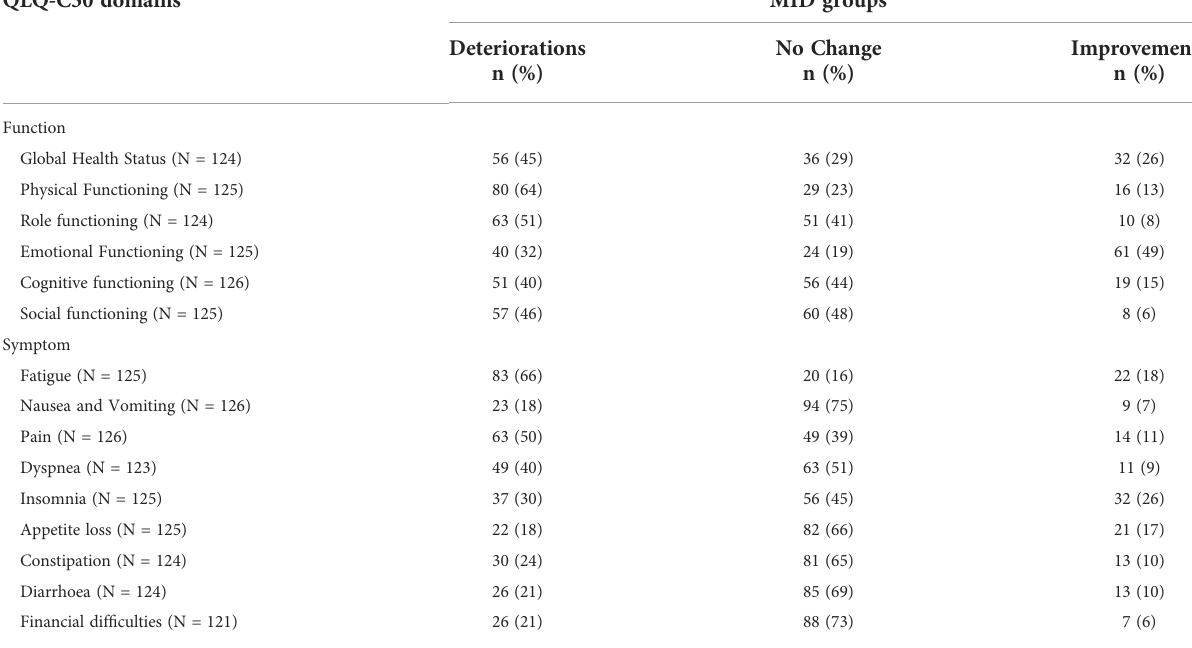
TABLE 2 Patients with deteriorations, improvements, and no change in QLQ-C30 domain scores, de fi ned by minimal important difference (MID) thresholds provided by Cocks et al. (2011)